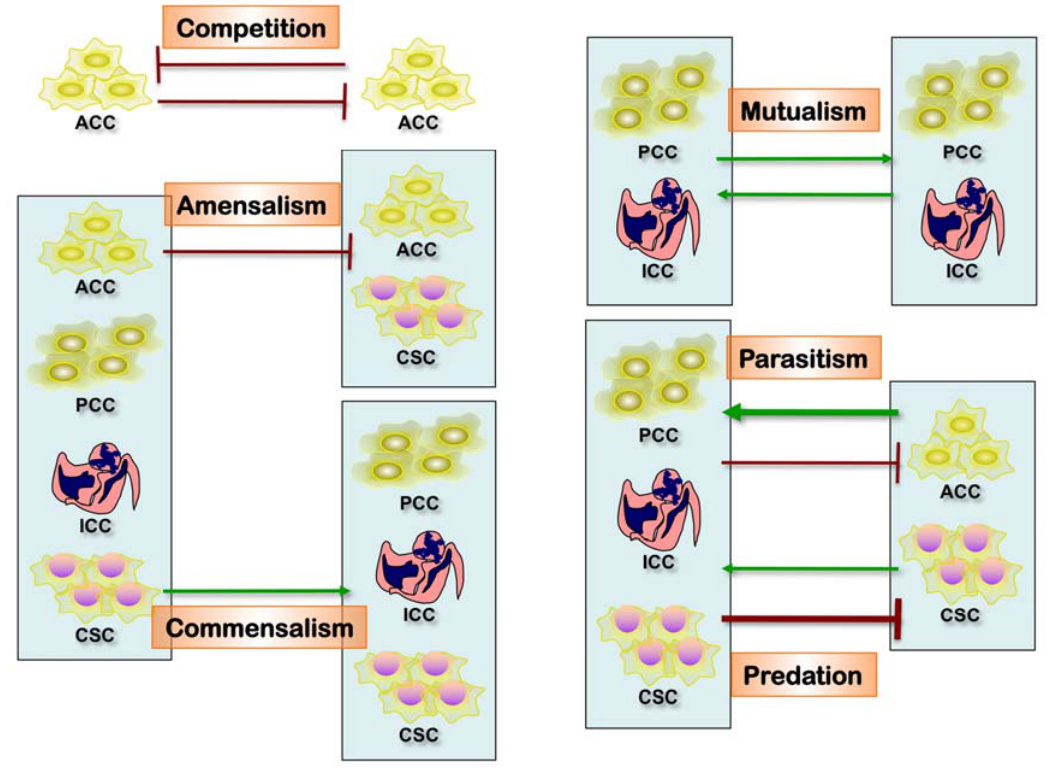
Figure 3. Interaction between tumor cell clones. This process includes competition, amensalism, commensalism, mutualism, parasitism and predation; the outcome is a higher level of complexity of tumor heterogeneity at the cellular